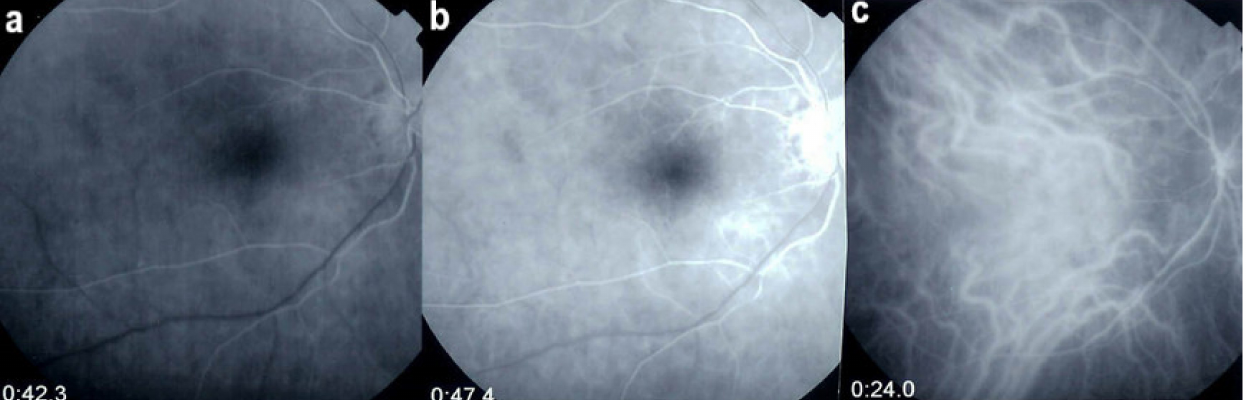
Figure 42. Pseudo-delay in retinal circulation. A patient in the exudative stage of BRC exhibits no fluorescein marking of large veins at 42.3 s. ( a ) and 47.4 s ( b ) after injection. This is not due to an increase of arterio-venous circulation time, but to massive extrusion of the small fluorescein molecule from retinal capillaries and larger vessels. This phenomenon is revealed by ICGA; opacification of large veins occurs normally at 24.0 s ( c ), as the large ICG complex does not extrude from retinal vessels.